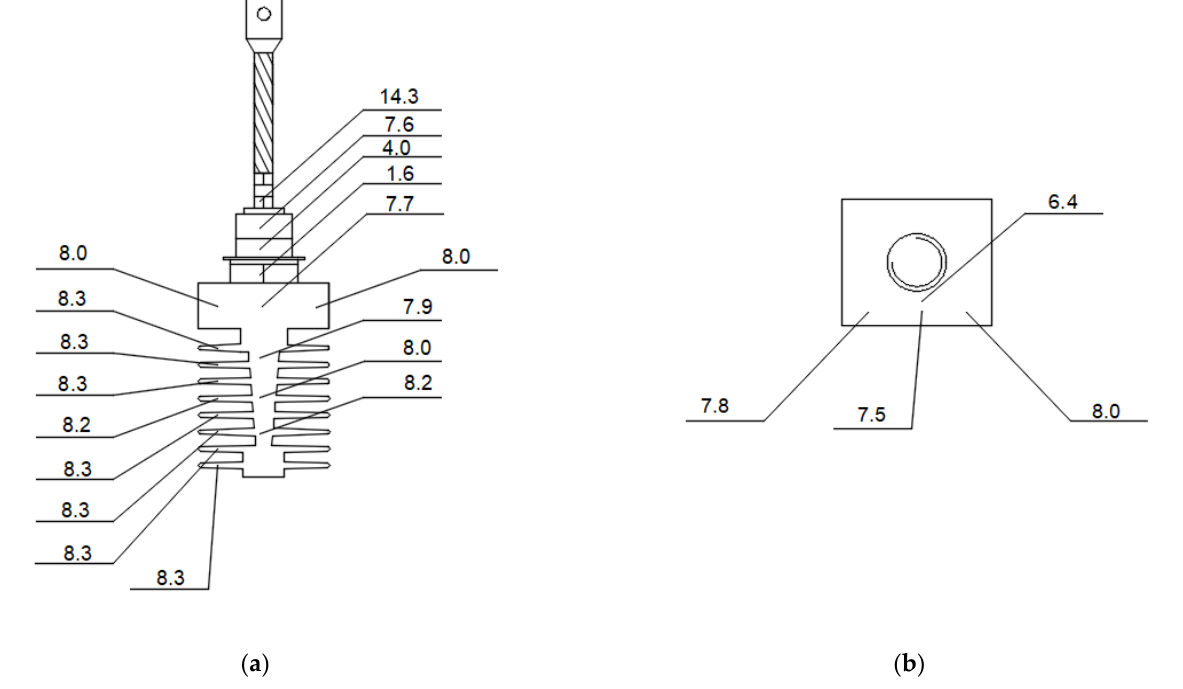
Figure 17. Differences ( T j – T s ) between the junction temperature ( T j ) and the surface temperatures ( T S ) (from Tables 6 and 7) at points presented in Figure 2 for a power of Pj = 11.56 W: ( a ) side view; ( b ) top view.